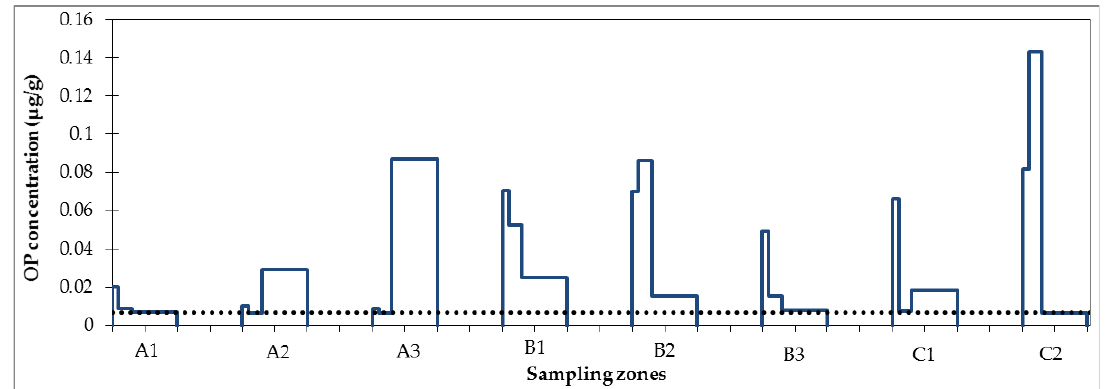
Figure A7. Concentrations of OP measured in composite cores of each sampling zone. Within each zone, concentrations from cores taken at depths of 0–5 cm, 5–15 cm and 15–50 cm are represented to scale from left to right. The dotted line represents the concentration measured in the initial soil sample. Water 2019 , 11 , x FOR PEER REVIEW 31 of 37